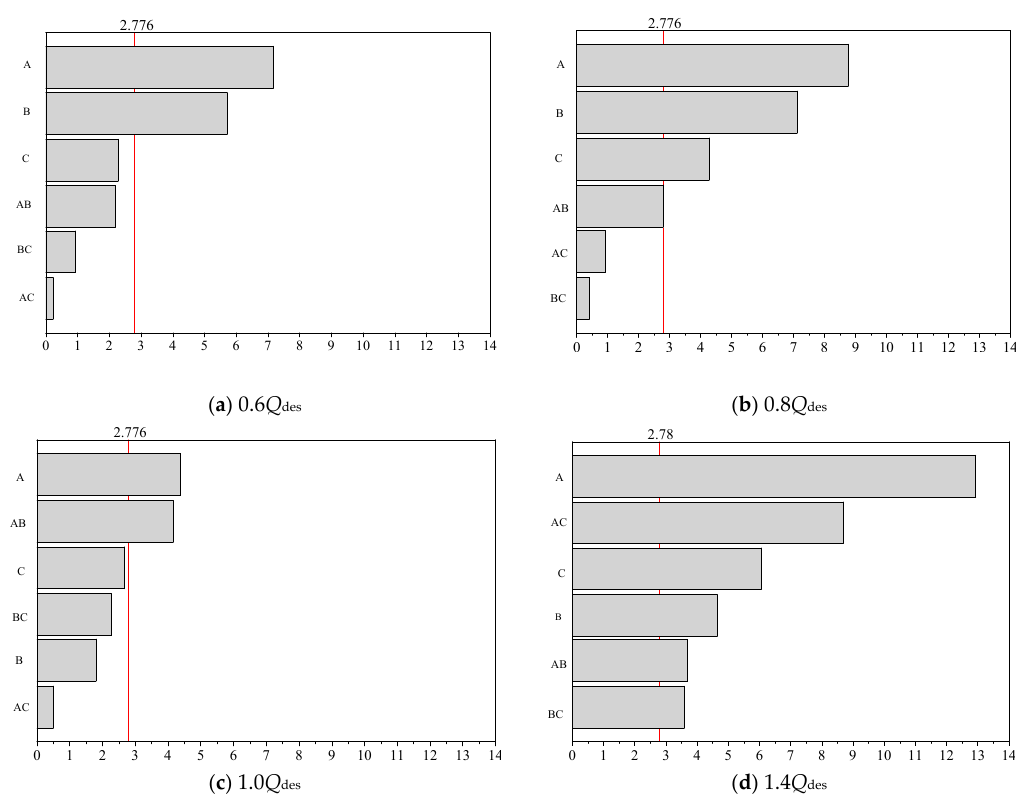
Figure 8. Pareto diagram of efficiency under different operation conditions.